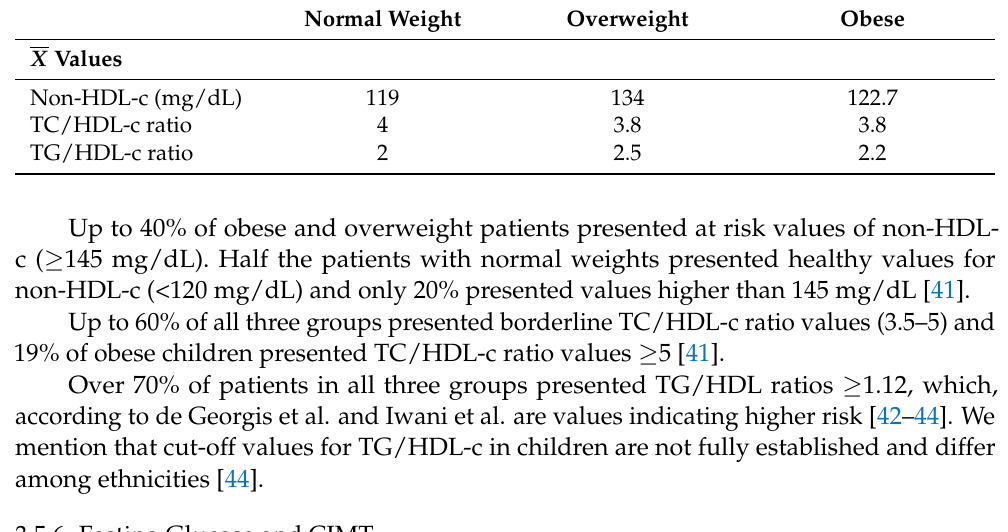
Table 9. Means of non-HDL-c, TC/HDL-c ratio and TG/HDL-c ratio across the three groups. Normal Weight Overweight Obese